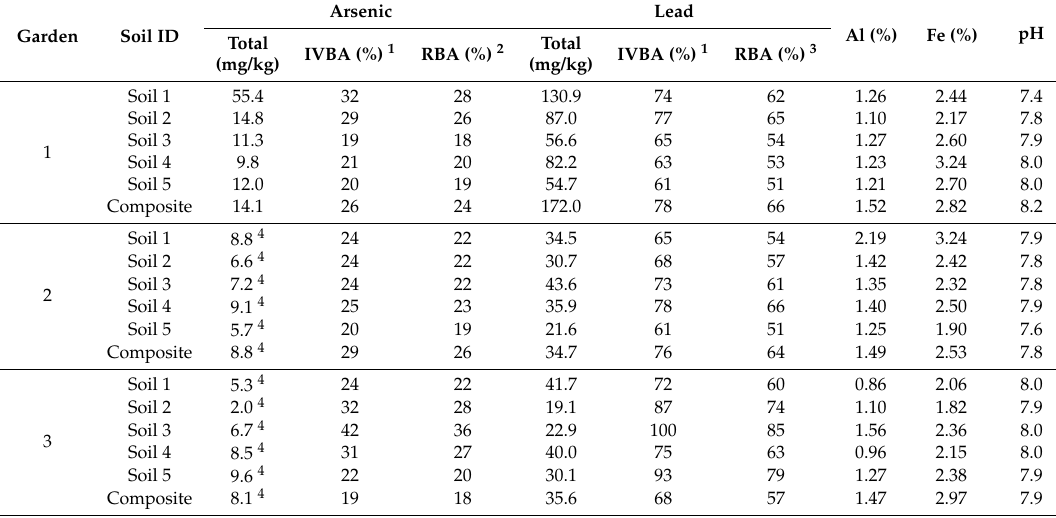
Table 1. Total bioaccessible and bioavailable As and Pb in study soils and additional soil properties of